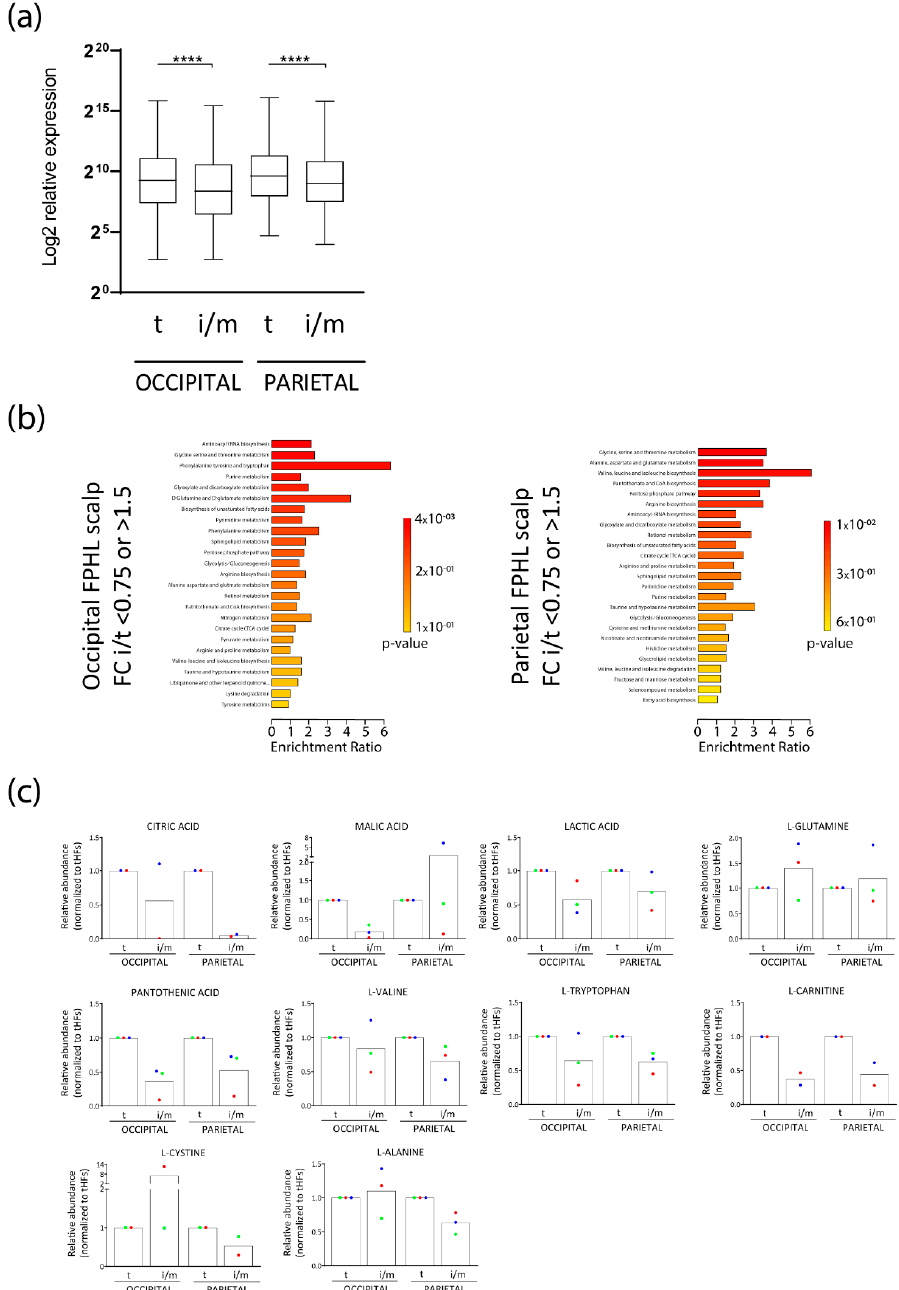
Figure 2. Intermediate HFs from FPHL patients show metabolites deficiency. ( a ) Log2 average relative expression of the n = 141 identified metabolites in at least two FPHL patients in terminal (t) and intermediate/miniaturized (i/m) hair follicles from occipital and parietal scalp skin samples from n = 3 FPHL donors. Box-plot with whiskers to minimum and maximum of the Log2 average relative expression data created with GraphPad9.0, n = 141, Friedman test p < 0.0001, Dunn’s multiple comparison test **** p < 0.0001. ( b ) Metabolite set enrichment analysis was performed using MetaboAnalyst 5.0 (University of Alberta, Edmonton AB T6G 2E8, Canada) (https://www.metaboanalyst.ca/MetaboAnalyst/home.xhtml, accessed on 30 March 2022) as basis differentially abundant (FC (i-m/t) < 0.75, FC (i-m/t) > 1.5) metabolites in intermediate/miniaturized versus terminal hair follicles in the FPHL occipital ( left ) and parietal ( right ) scalp region. ( c ) Relative abundance of selected metabolites in intermediate/miniaturized and terminal hair follicles from occipital and parietal FPHL scalp from n = 2–3 donors (green, red, and blue circles). Relative abundance normalized to corresponding terminal